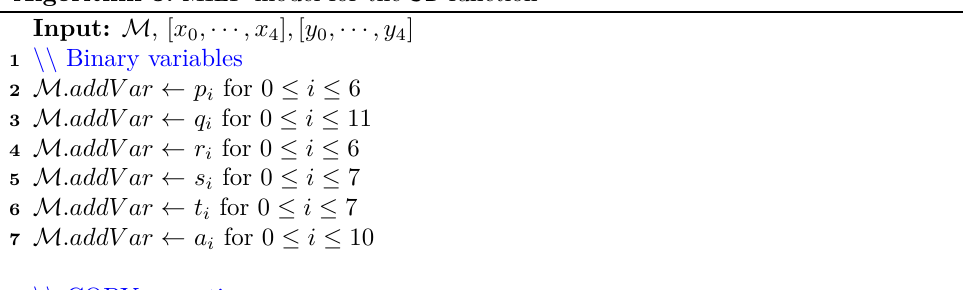
Algorithm 3: MILP model for the SB